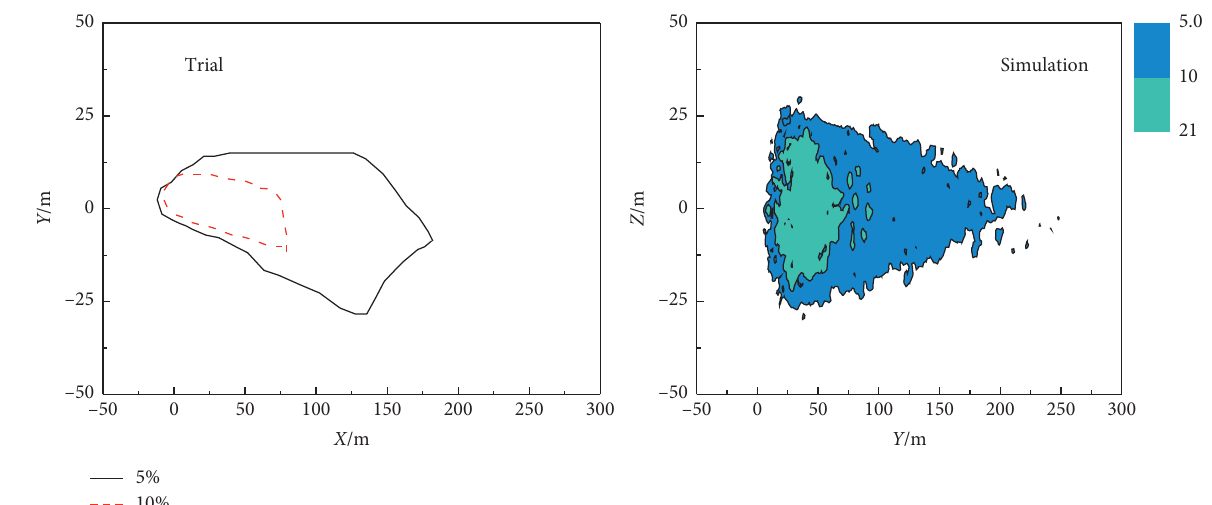
Figure 7: Comparison of Coyote 3 trial and Fluent simulation for LNG horizontal volume-concentration distribution ( Z � 1 m and t �